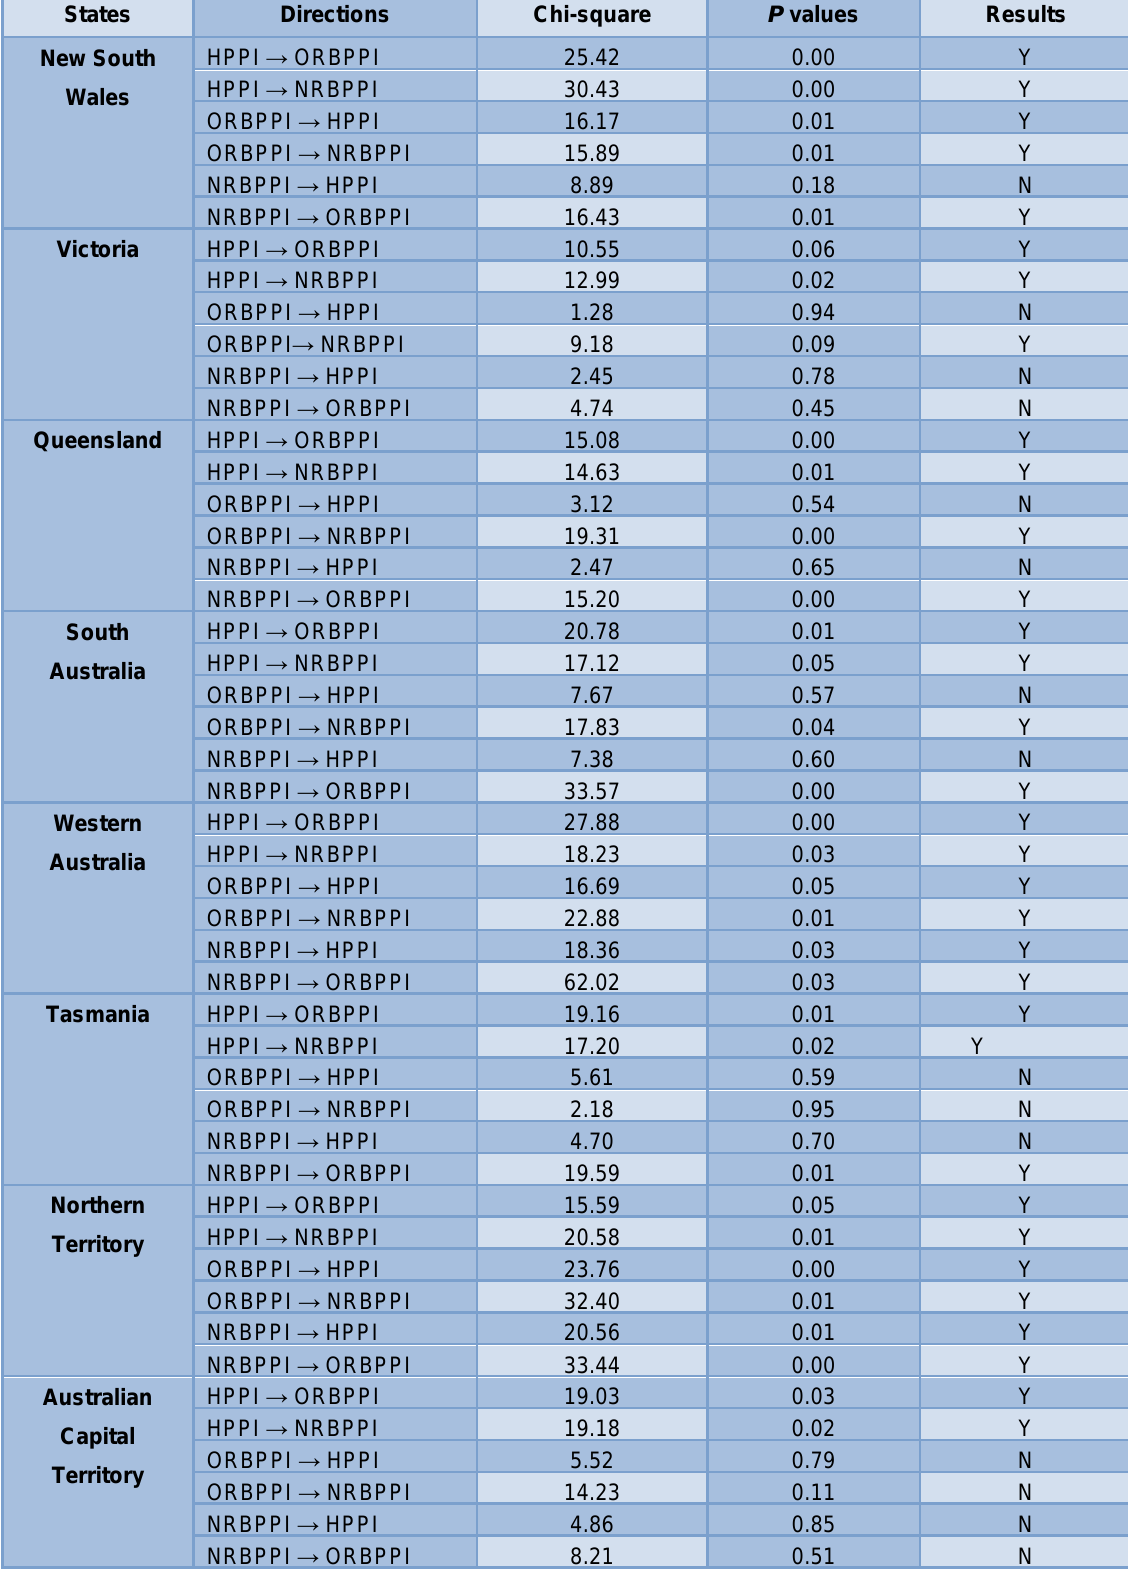
Table 4: Granger causality tests of construction output PPI in